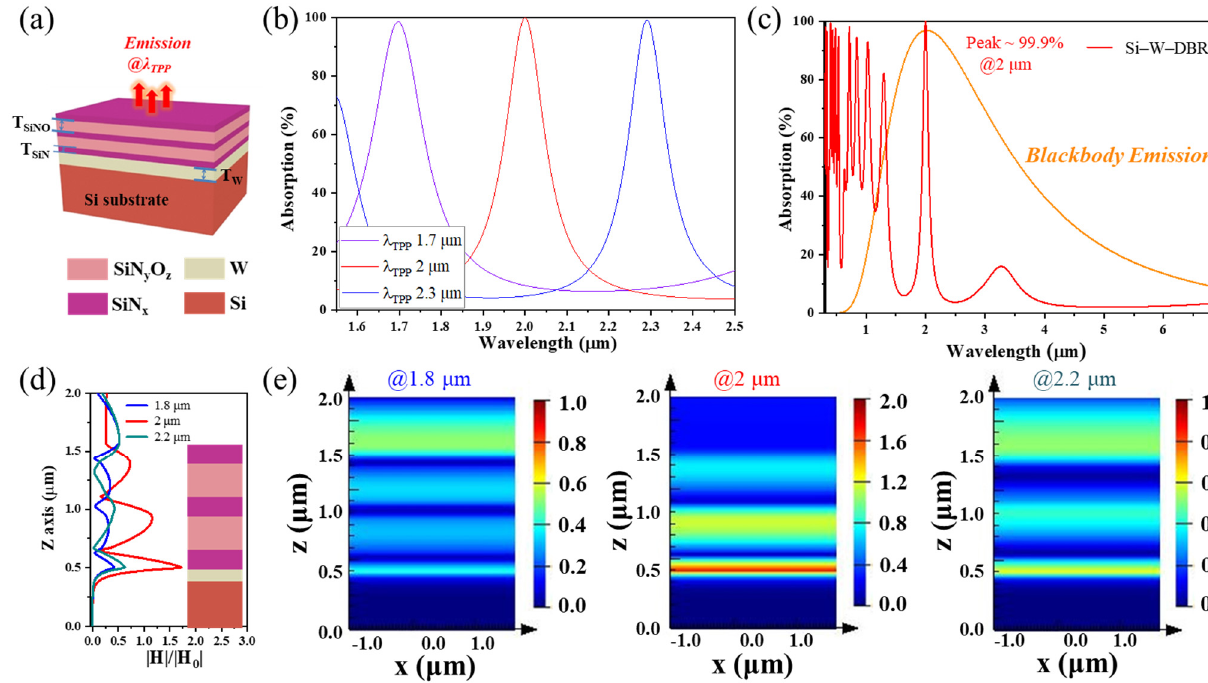
Figure 1. ( a ) Schematic diagram of a wavelength-selective and narrowband thermal emitter with Si-W-SiN/SiNO multilayers structure; ( b ) simulated absorption spectra of Si-W-SiN/SiNO emitter with TPP resonance peaks at 1.7, 2, and 2.3 µ m, respectively. The wavelengths range from 1.5 to 2.4 µ m; ( c ) simulated absorption spectra of Si-W-SiN/SiNO emitter with TPP resonance peak at 2 µ m. The wavelengths range from 0.3 to 7 µ m; ( d , e ) cross-sectional plot along the z axis of normalized magnetic field intensity distribution of the Si-W-SiN/SiNO structure at a wavelength of 1.8, 2.0, and 2.2 µm.